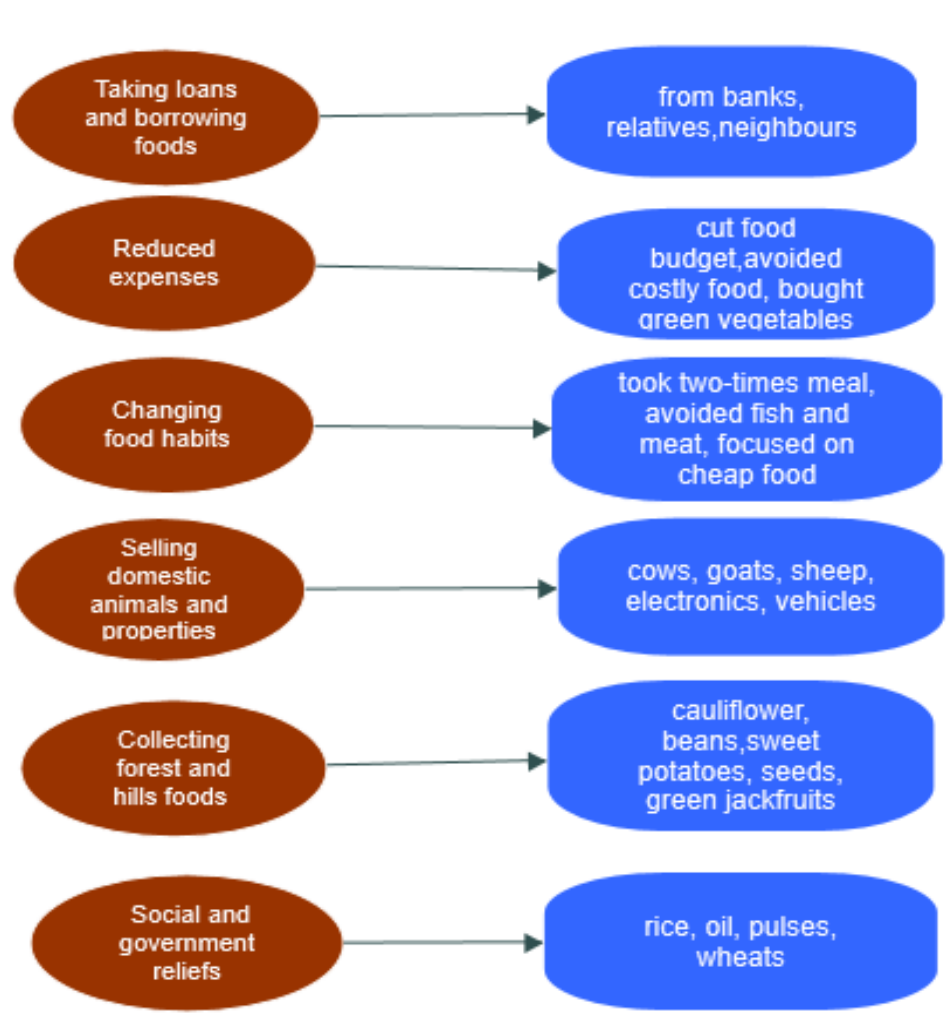
Figure 4. Indigenous coping